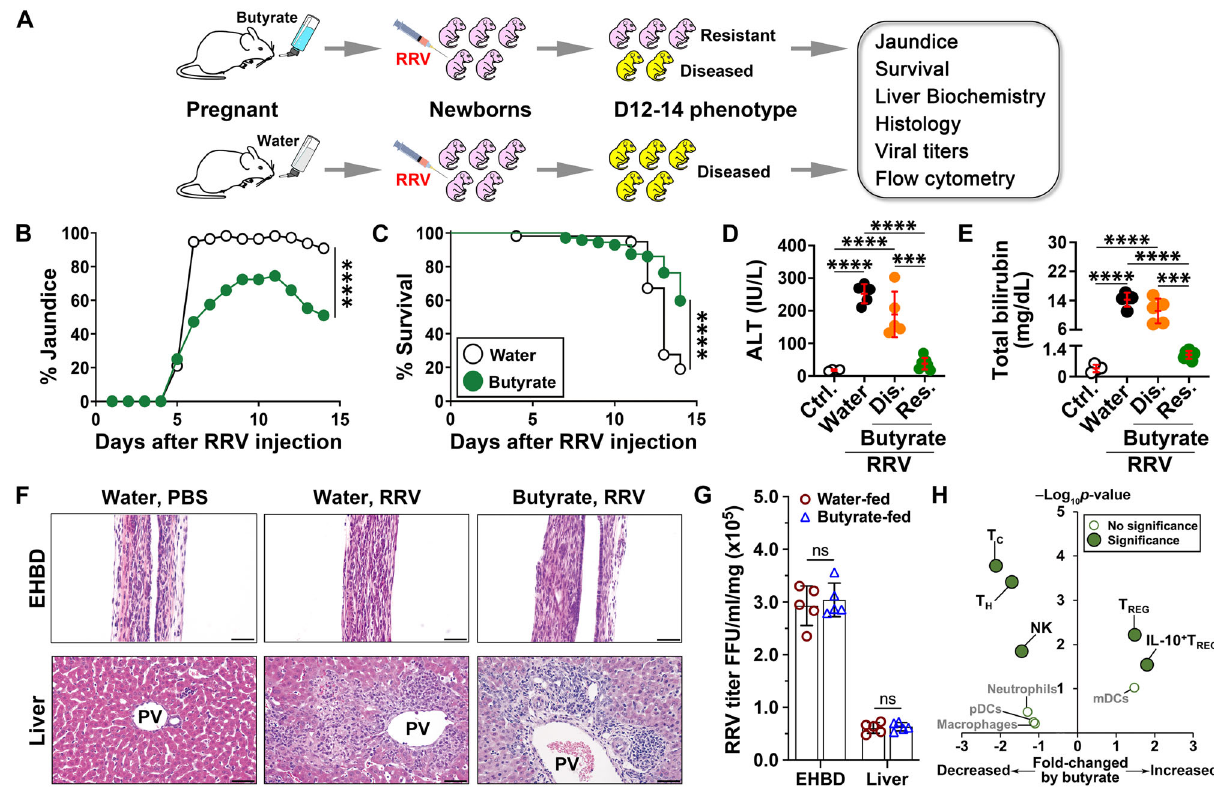
Fig. 1 Maternal intake of butyrate suppresses liver and bile duct injury in the offspring. A Schematic representation showing butyrate or water administration followed by evaluation of biliary disease in rotavirus (RRV)-infected mice. B Jaundice (generalized linear mixed effect model with logit link and two-sided Wald test with Bonferroni correction; **** p < 0.0001) and C survival (two-sided log-rank test; **** p < 0.0001) rates in RRV-infected